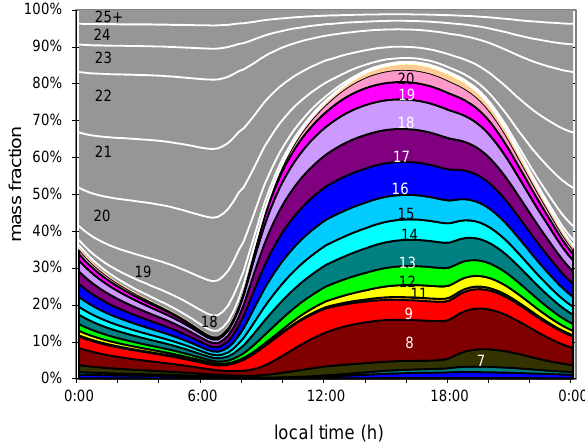
Fig. 7. Composition of simulated organic aerosol within Mexico City. SOA (colors) and POA (grey region) are sorted by carbon number of the individual aerosol